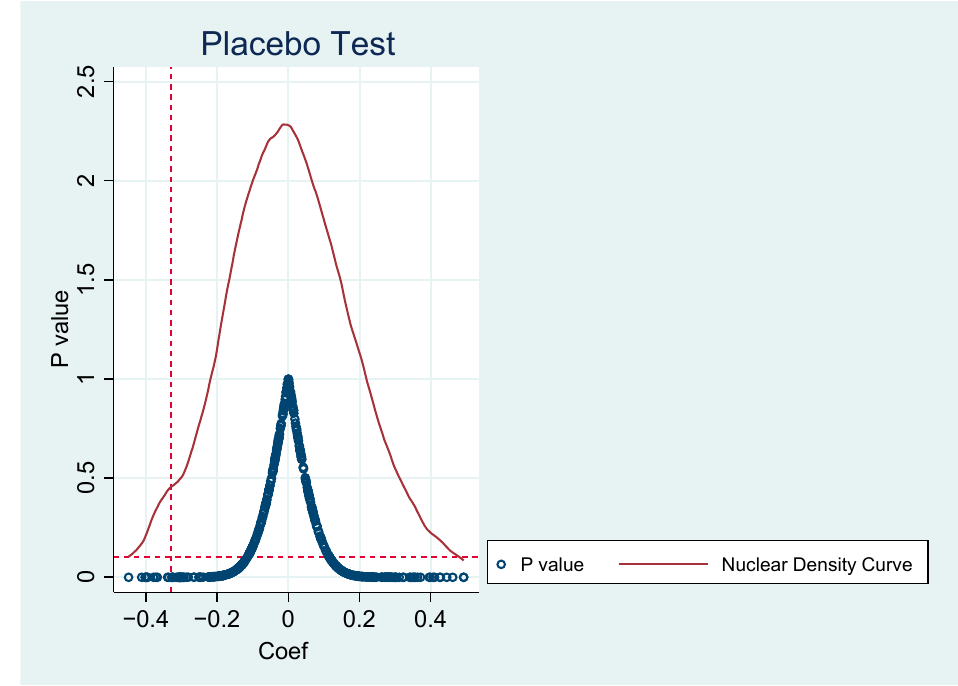
Figure 4. Placebo Test of Emission Permit Management Policies for Key Polluting Industries.